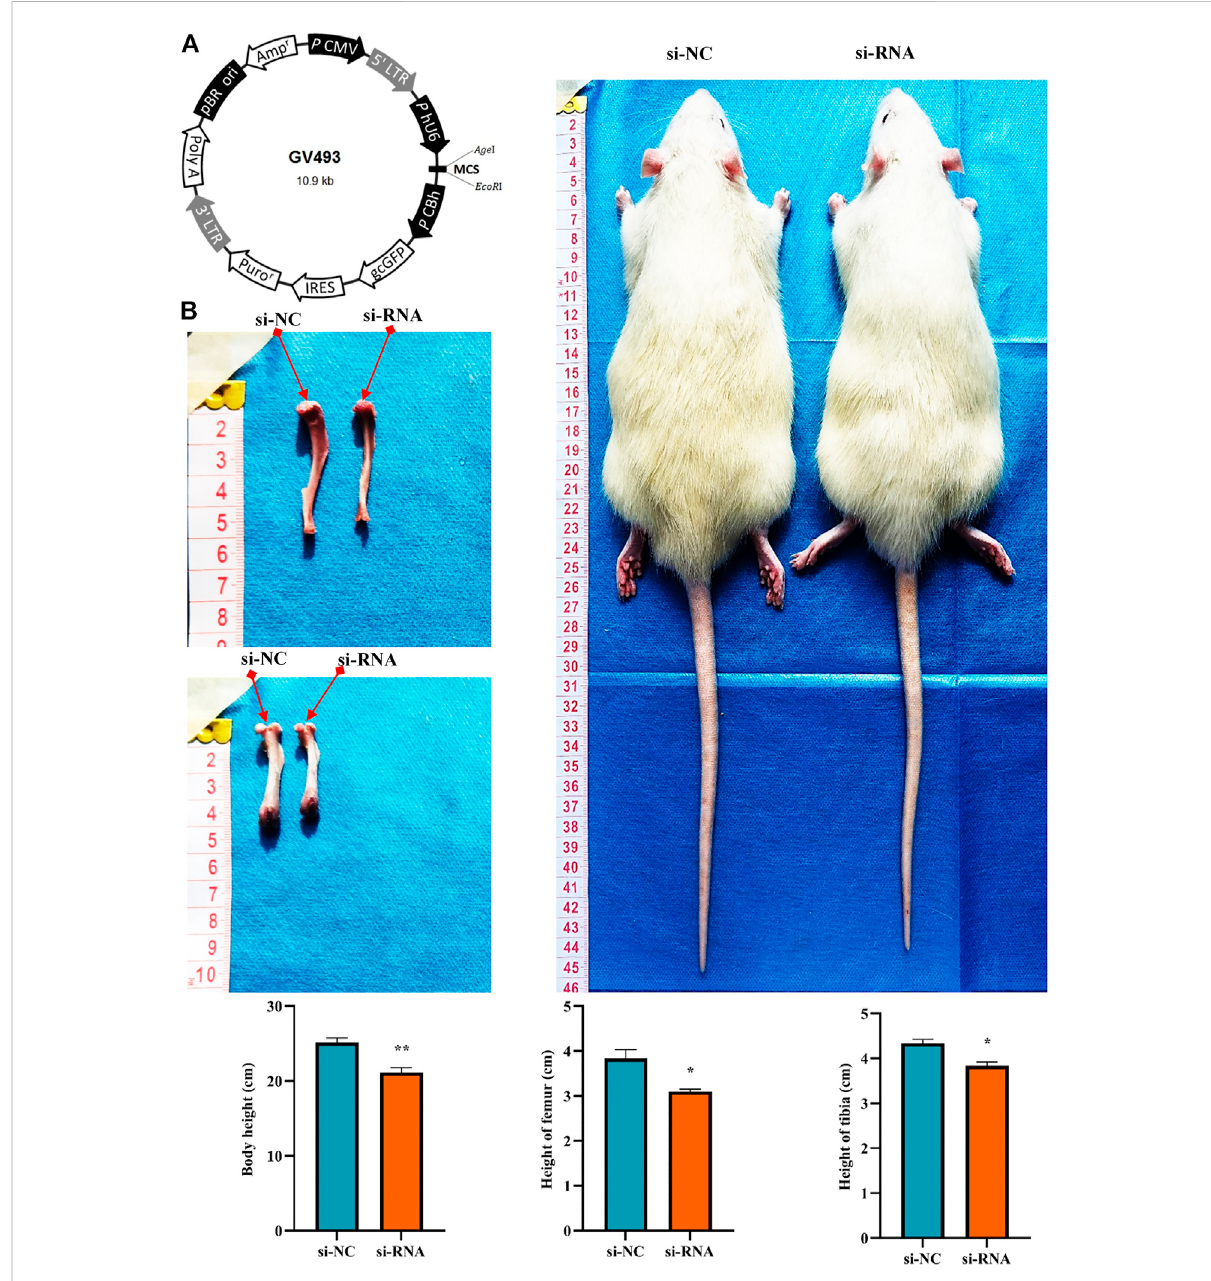
FIGURE 10 Knockdownofhsa_circ_0008870resultedinsmallerstatureinrats. (A) Hsa_circ_0008870knockdownlentivirus. (B) Comparedwiththeratsin the negative control group, changes in body size, tibia and femur length of hsa_circ_0008870 knockdown rats. * p < 0.05 and ** p <